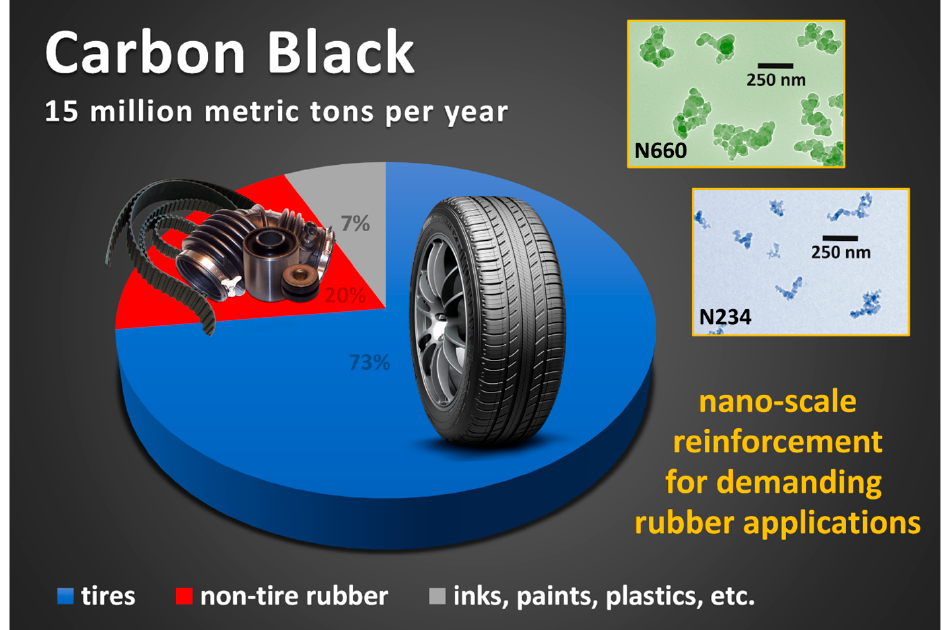
Figure 1. Global annual production of carbon black and its distribution in the indicated end-use industrial application areas, based on reported data [5]. Representative examples of carbon black (CB) aggregates are shown in the transmission electron microscopy (TEM) images for N234 and N660 types to show the nano-scale morphologies that are key to reinforcement.